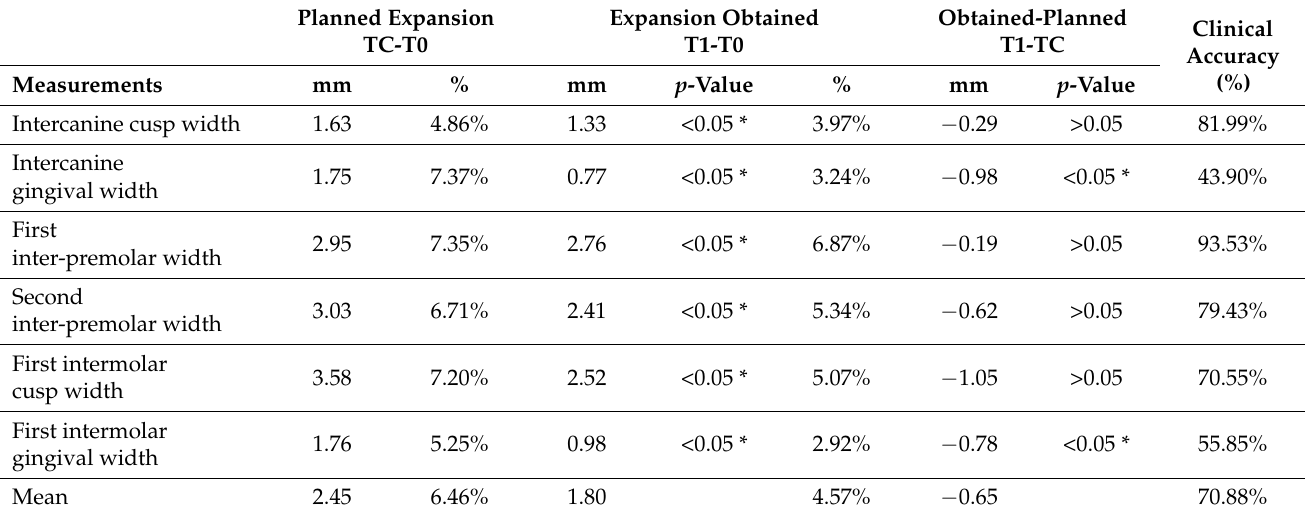
Table 2. Difference between measurements in planned expansion (TC-T0) and the expansion obtained (T1-T0), and clinical accuracy